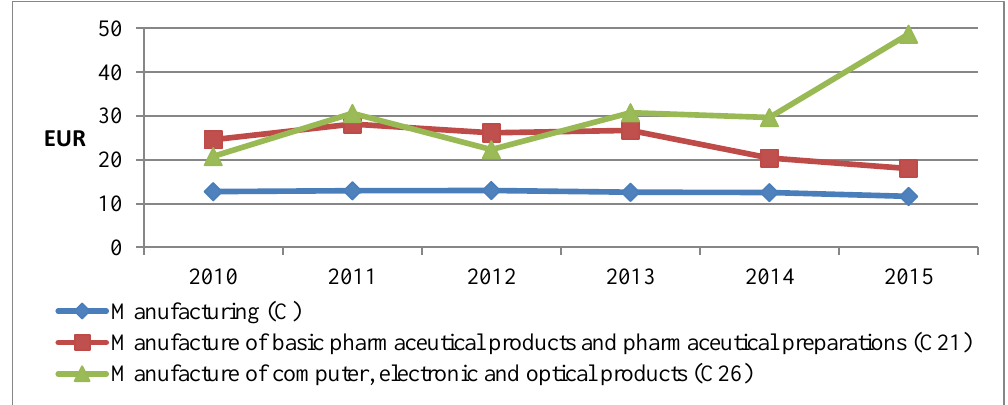
Fig. 2. Dynamics of the real value added per hour worked in 2010–2015,